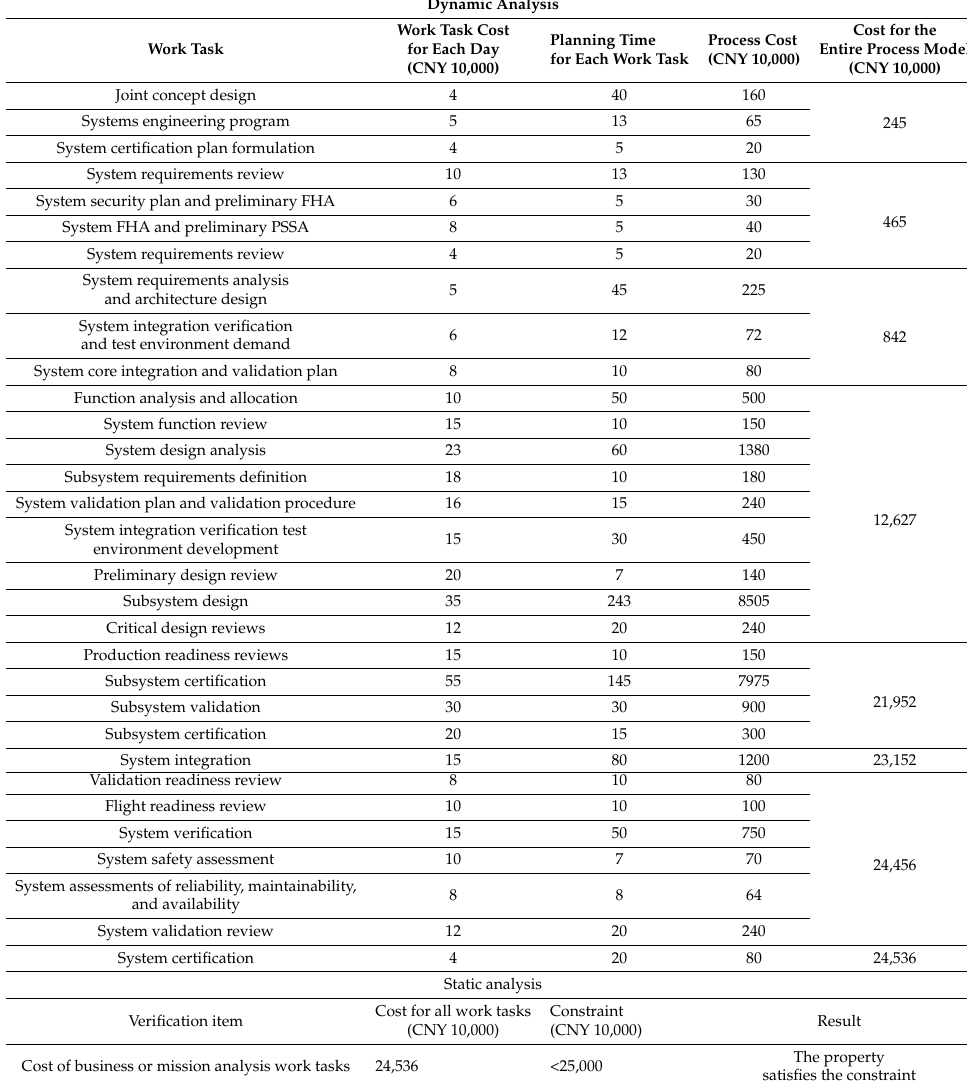
Table 5. Properties for each work task in the KARMA